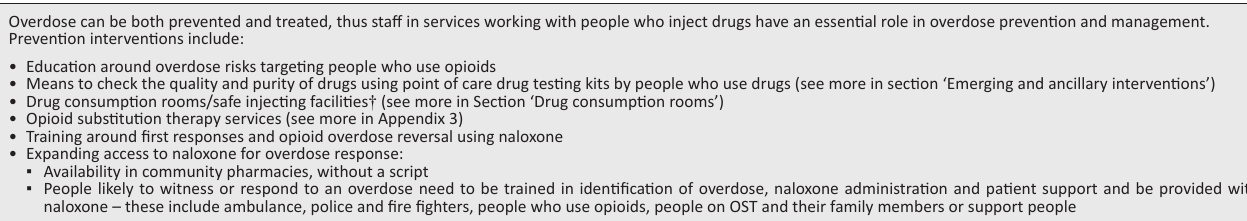
FIGURE 2: Algorithm for managing sedative or stimulant overdose. 19,87